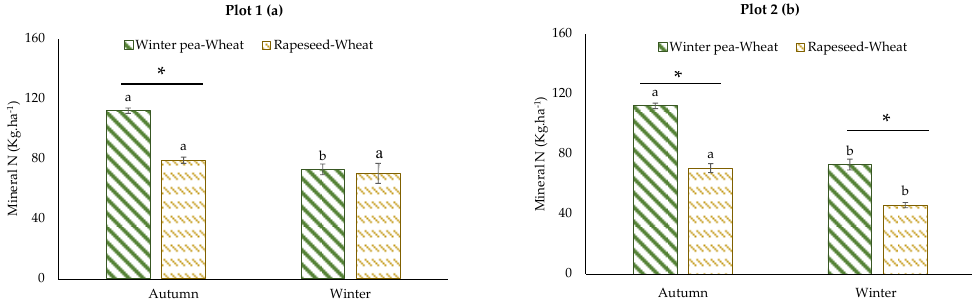
Figure 5. Effects of crop successions with fertilization on soil mineral N rate (0–60 cm) at two sampling dates (autumn and winter) in the two studied plots: ( a ) plot 1, ( b ) plot 2. Error bars on data points represent the standard errors of the mean of three replicates ( n = 3). Letters indicate statistical significance between the sampling dates (autumn and winter) and asterisks indicate statistical significance between the two successions (winter pea–wheat vs. rapeseed–wheat) at p < 0.05 according to Tukey’s test.